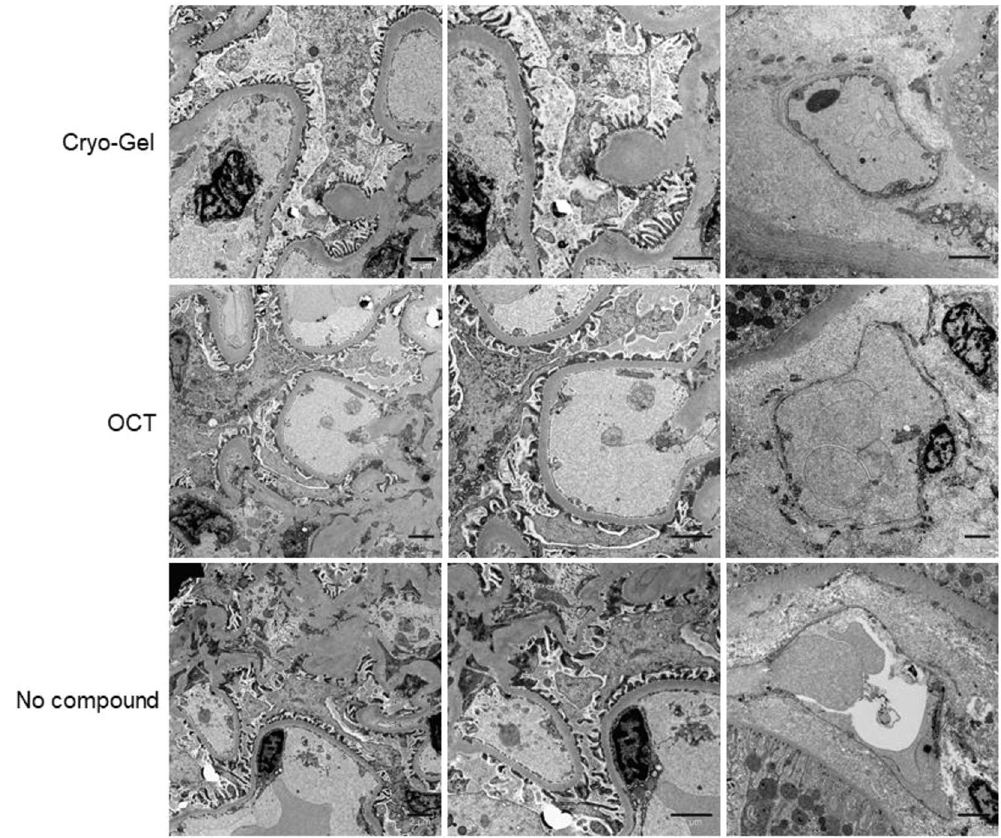
Figure 7. Electron microscopy for samples embedded with Cryo-Gel, OCT and without compound. Left: glomerular filtration membrane (magnification 4400x); middle: higher magnification of glomerular filtration membrane (magnification 7100x); right: peritubular capillary (magnification 7100x, 4400x and 5600x, respectively). Scale bar = 2 µ